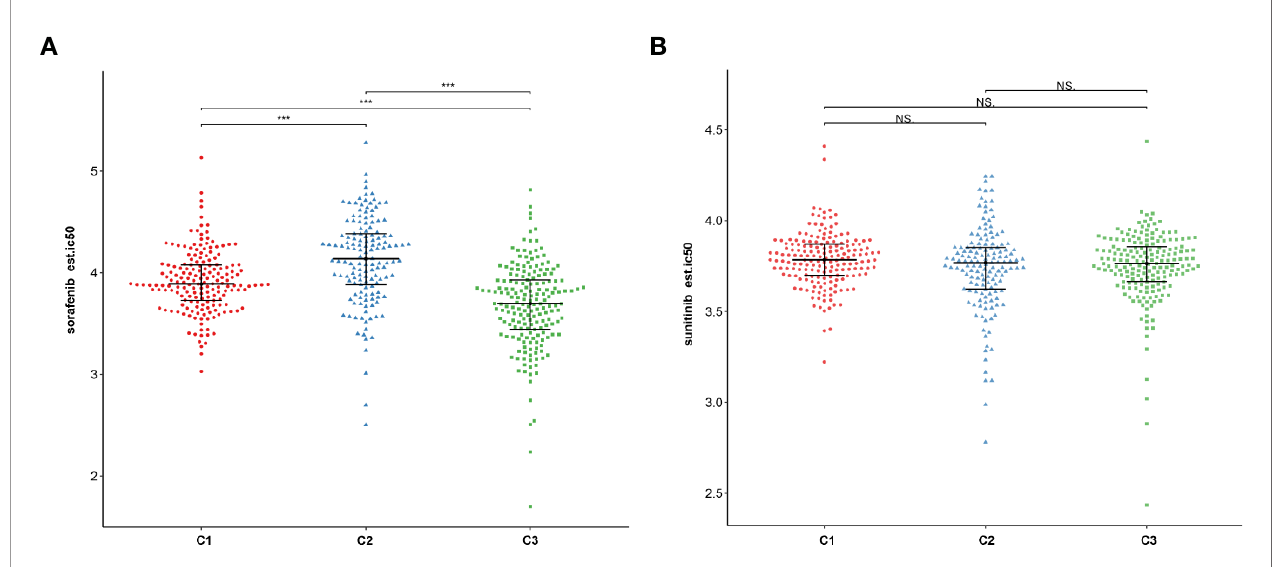
FIGURE 12 | The relationship between chemo drug and three subtypes. (A) Sorafenib. (B) Sunitinib. NS: Not Signi fi cant, ***: P <